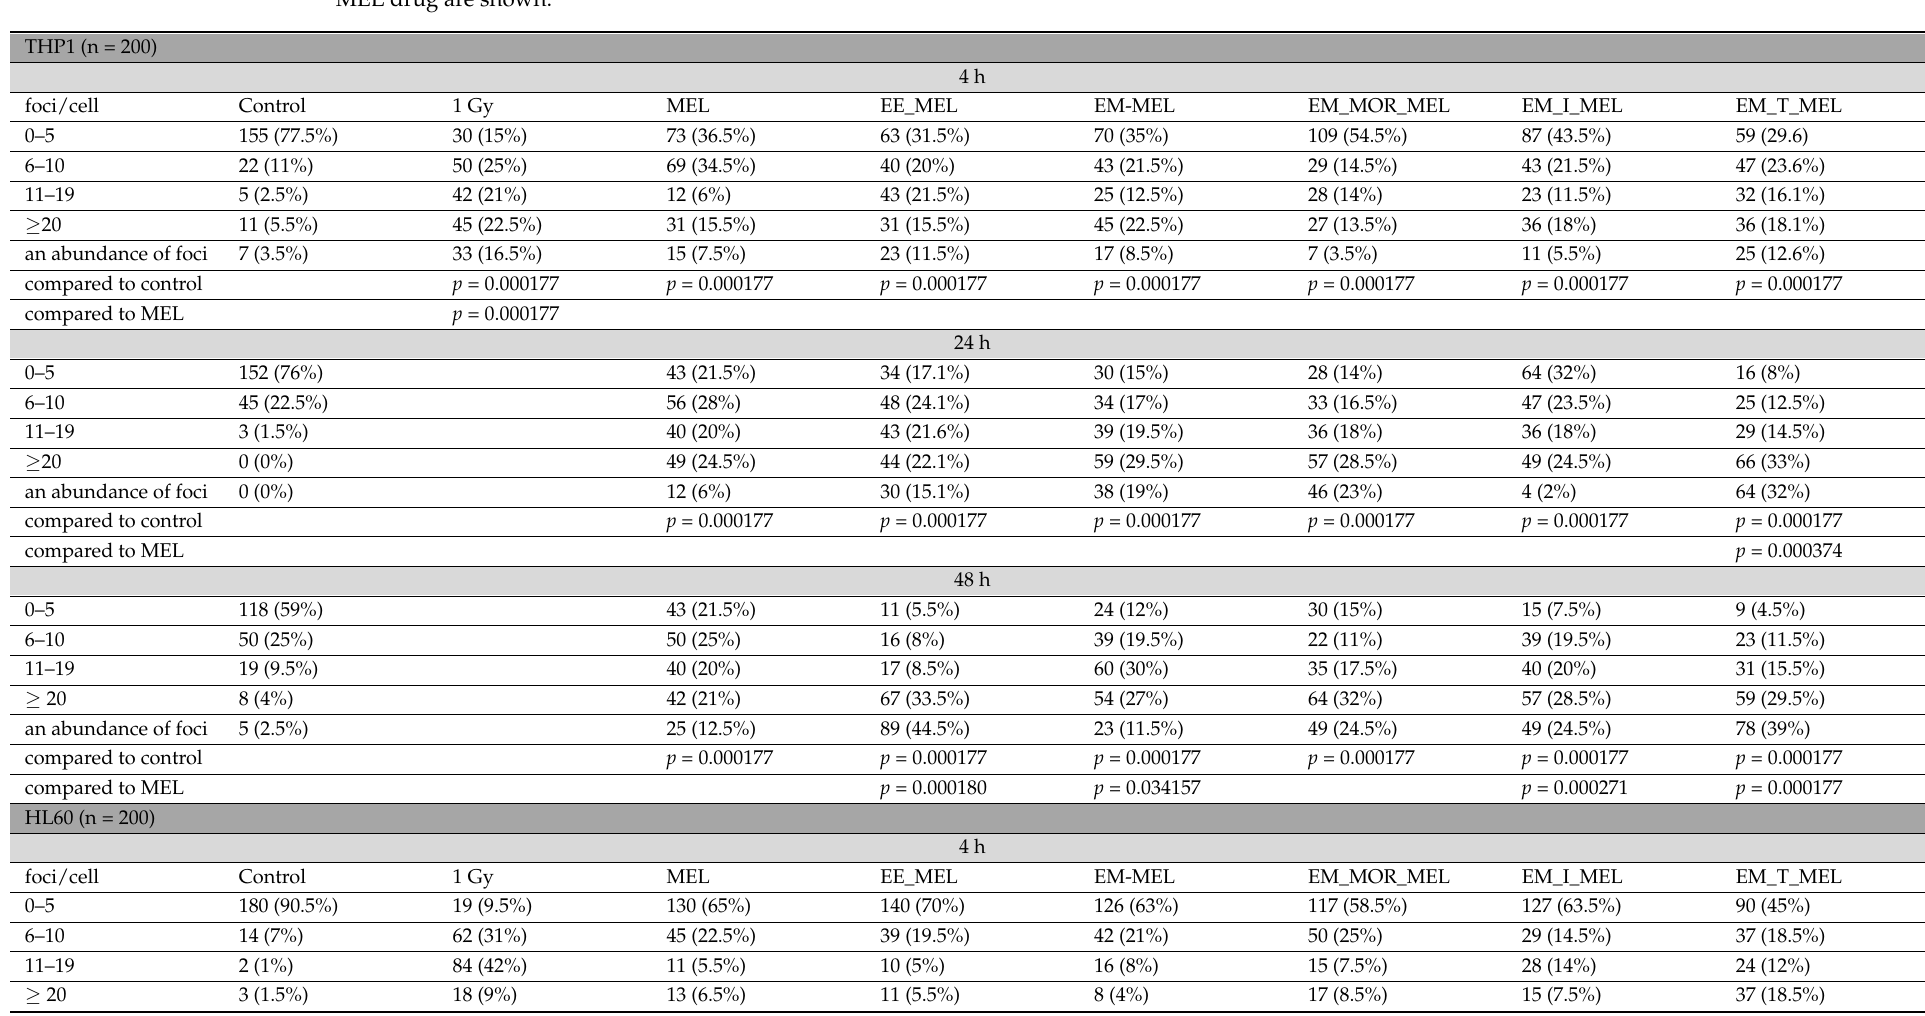
Table 1. γ H2AX foci per cell after treatment with melphalan and its derivatives. Data are the number of foci per cell (%). All data are from two biological assays (n = 200; 100 cells counted in each case). Statistically significant p values (ANOVA with Tukey’s post hoc ) for cells > 5 foci/cell compared to the control or original MEL drug are